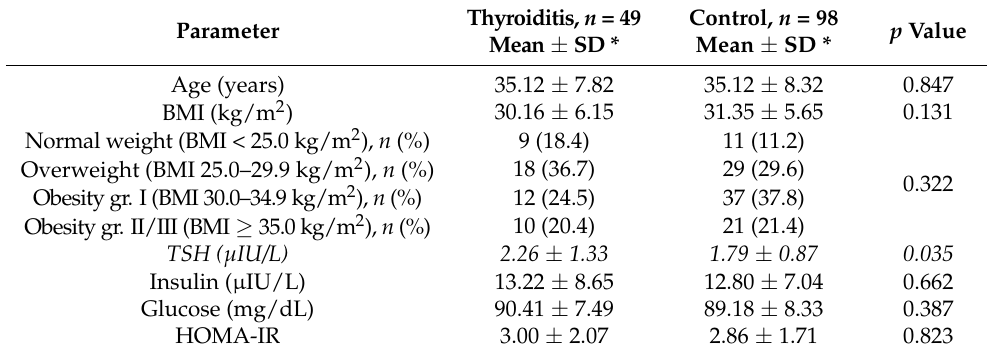
Table 1. Demographic, anthropometric and laboratory data of the women from the study and control groups. Significant differences are emphasized in italics. Thyroiditis, n = 49 Parameter Mean ± SD